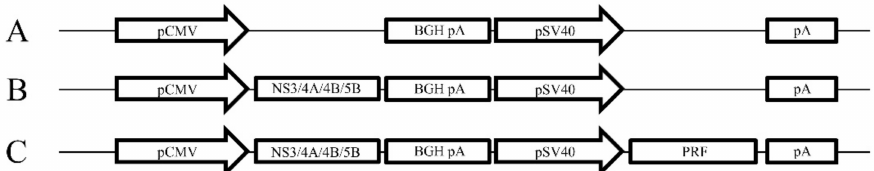
Figure 1. Schematic map of the vaccine constructs. (A) pVAX empty construct, (B) pVAX encoding NS3, 4A, 4B and 5B downstream of the CMV promoter (pNS3 / 4A / 4B / 5B) and (C) pNS3 / 4A / 4B / 5B encoding Perforin (PRF) downstream of the SV40 promoter (pNS3 / 4A / 4B /